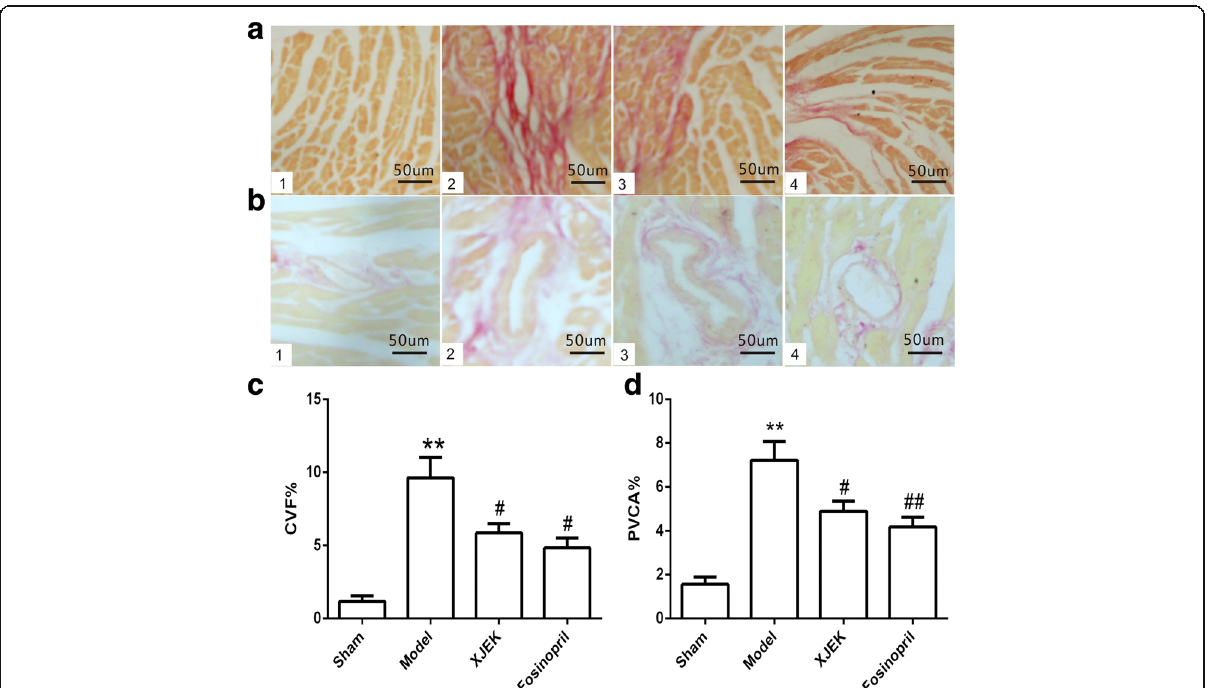
Fig. 4 Effect of XJEK on cardiac tissue PVCA and CVF of MI mice (VG staining, magnification ×400). a Representative images of histological section of CVF (VG staining, magnification ×400); b Representative images of histological section of PVCA (VG staining, magnification × 400); c Quantitative analyses of CVF (mean ± SEM, n = 6 – 9); d Quantitative analyses of PVCA (mean ± SEM, n = 6 – 9); (1) Sham group; (2)Model group; (3) XJEK group; (4) Fosinopril group. * P < 0.05, ** P < 0.01 vs. Sham group; # P < 0.05, ## P < 0.01 vs. Model